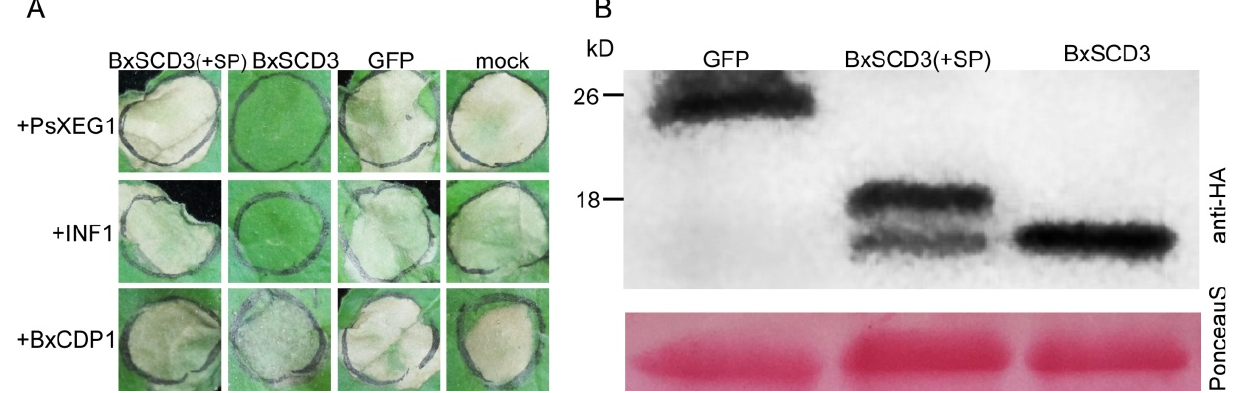
Figure 1. BxSCD3 suppresses PsXEG1 ‐ and INF1 ‐ induced cell death in Nicotiana benthamiana when secreted into the intracellular space. ( A ) Representative N. benthamiana leaves at 7 days (d) after inoculation with Agrobacterium sp. strain GV3101 carrying BxSCD3 in vector PVX (pGR107). The infiltration assay was performed three times and, in each assay, three different plants with three inoculated leaves were used. ( B ) Immunoblot analysis of proteins from N. benthamiana leaves transiently expressing target proteins fused with anti ‐ hemagglutinin (anti ‐ HA) tags.